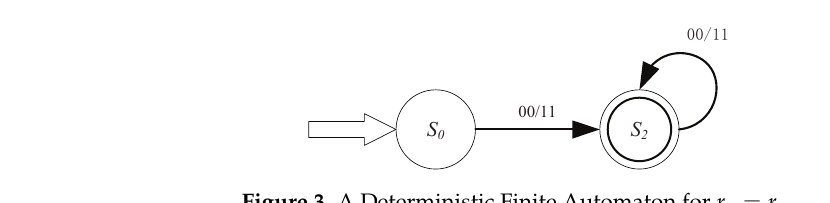
Figure 3. A Deterministic Finite Automaton for r p = r q .